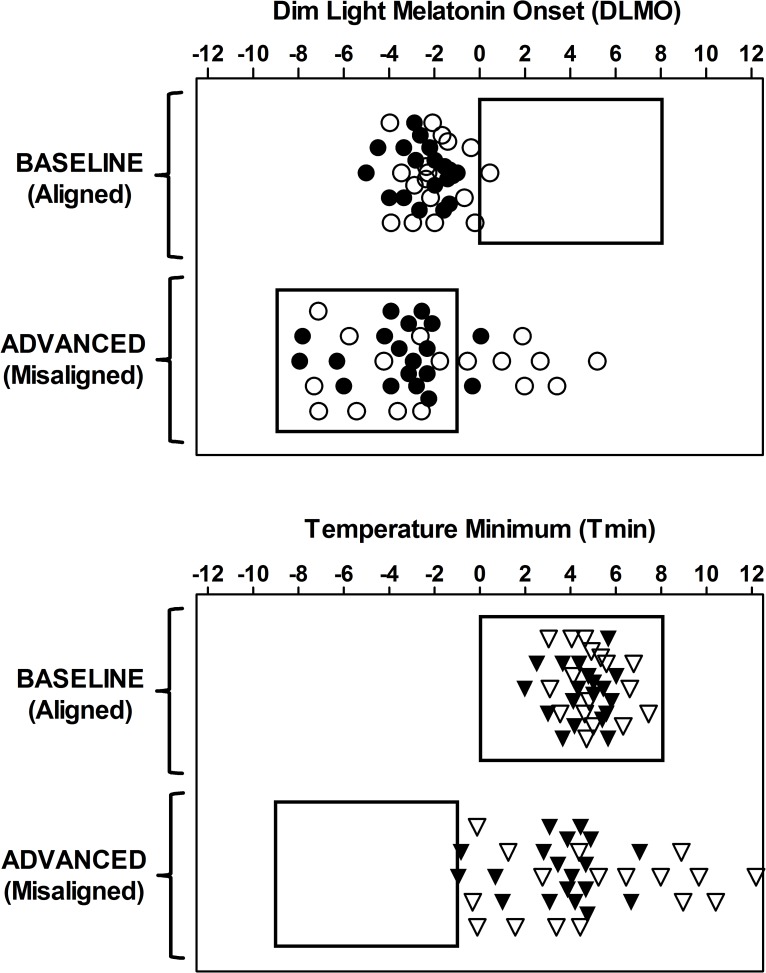
Dim light melatonin onset (DLMO) and estimated temperature minimum (Tmin) for each participant.DLMO was measured after the four baseline days on Chicago time (baseline/aligned) and after the three days on Kenya time (advanced/misaligned). Rectangles show the timing of the sleep/dark periods. Top: Circles show the DLMO relative to the baseline bedtime, with 0 representing the timing of the start of the scheduled baseline sleep period. Bottom: Triangles show the Tmin relative to baseline bedtime. The Tmin was calculated as the DLMO + 7 h. Filled symbols represent African-Americans and open symbols are European-Americans. The DLMOs and Tmins were properly aligned to the sleep/dark periods during baseline (DLMOs before sleep and Tmins within sleep), but were misaligned relative to the sleep/dark period during advanced days. The vertical symbol placement is for visualization purposes and has no relationship to days.